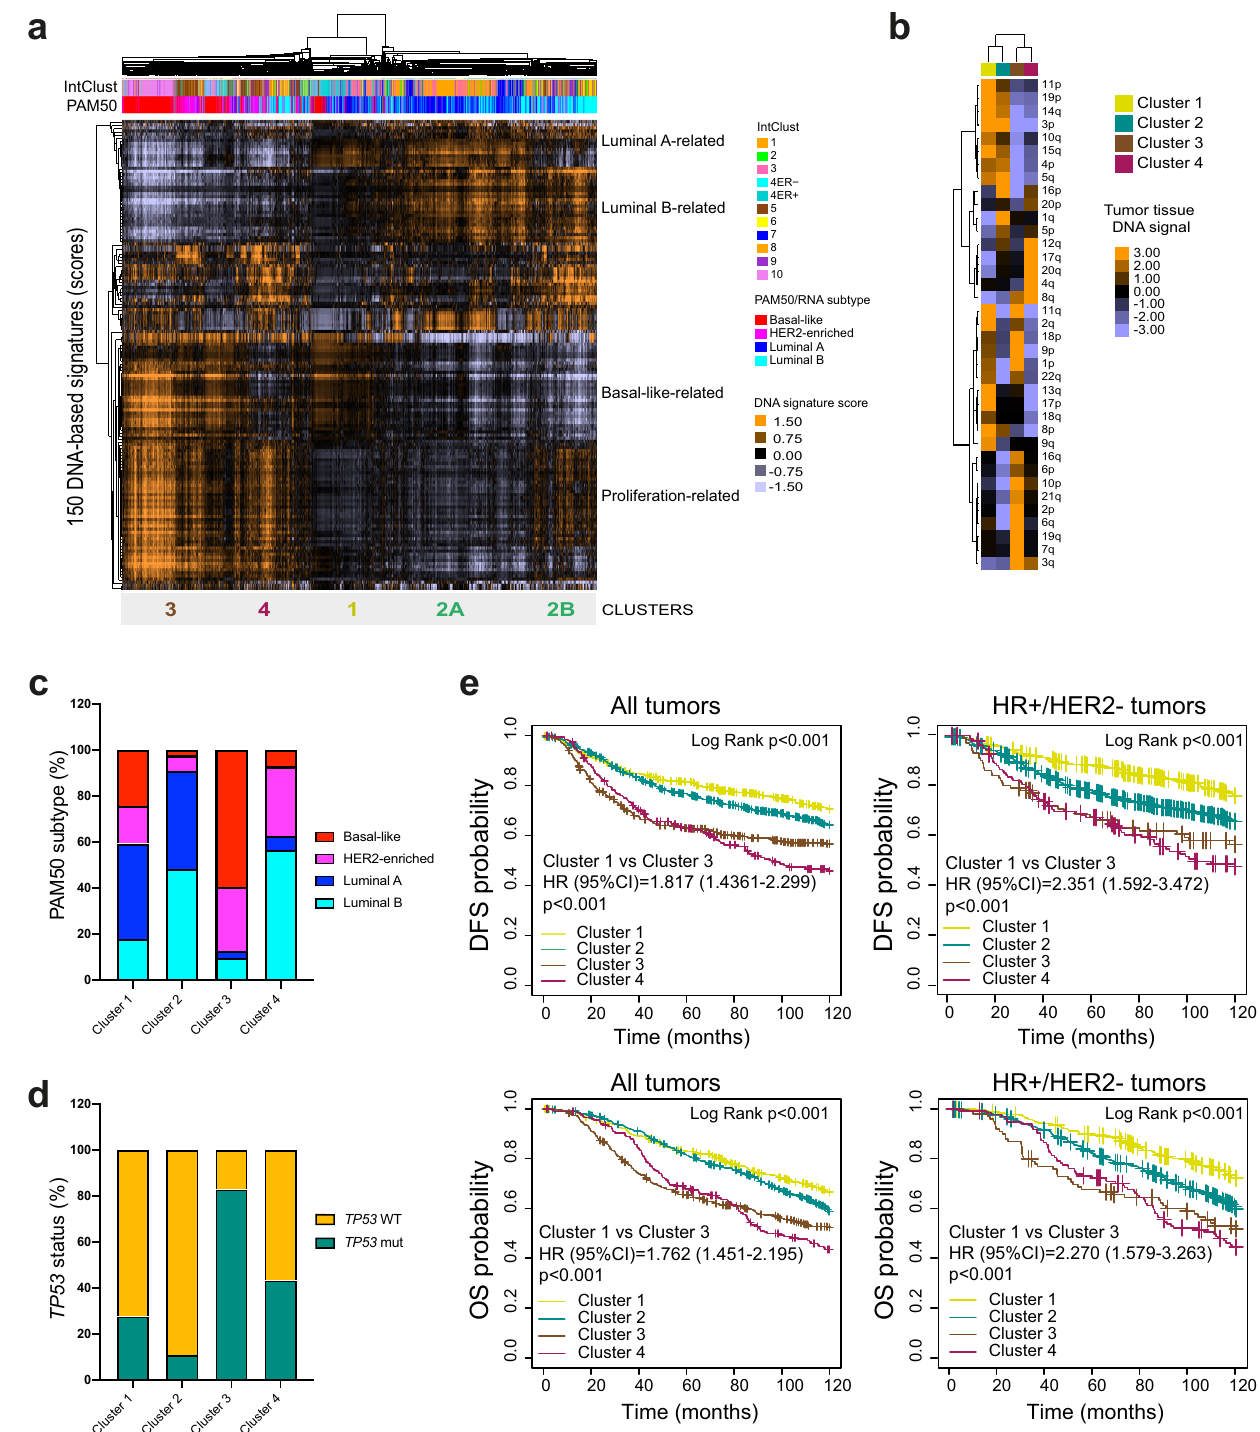
Fig.5|DNA-basedtumorpro fi lesintissuesamplesandassociationwithclinical outcomes.a Unsupervisedclusteranalysisof1,689tumorsamples(columns)from METABRIC dataset 29 and the 150 DNA-based signatures scores (rows). Orange and violet colors represent scores above and below the median value of the signature across the dataset. Below the array tree, the InctClust classi fi cation 29 and the PAM50 molecular subtypes are shown for each sample. The predictor of the 4 clusters, which was derived from plasma ctDNA data in the Plasma-1 cohort (see Fig. 4),was applied in METABRIC and the results for each sample are shown below the data matrix. b Heatmapofsignals from individualchromosomicregions found signi fi cantly associated with each cluster 1-4. Differentially represented segments